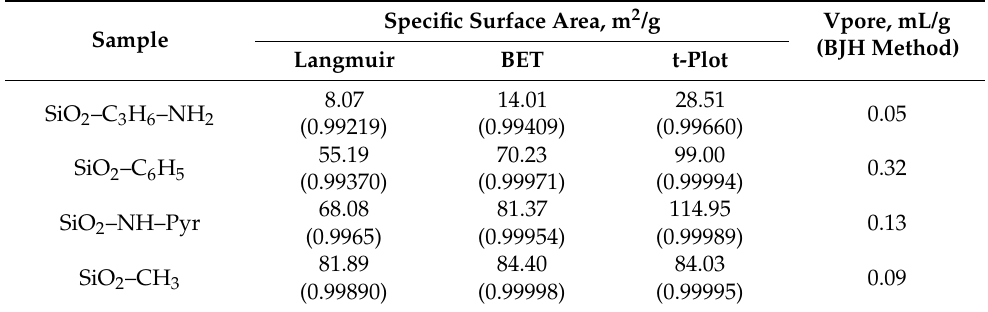
Table 2. Specific surface area values of supports with correlation coefficients and porosity values.